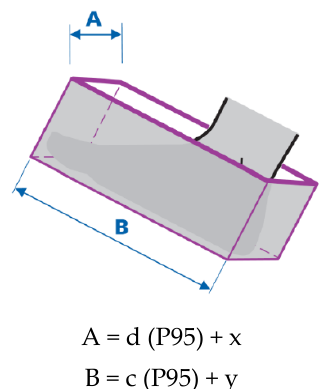
Figure 2. Dimensional allowances for foot width (x) and length (y) used in designing openings for one foot to access to ankle bone according to EN 547-2:1996 +A1:2008. A — Opening width , B — Opening length, d — Foot breadth, c — Foot length, P95 — 95th percentile [13,24]